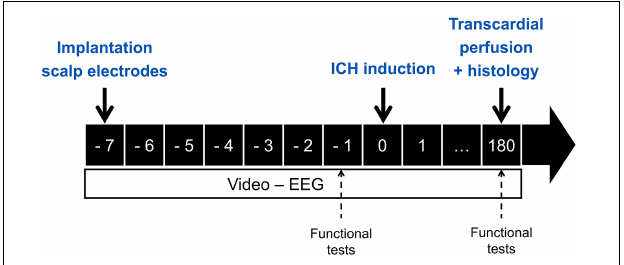
FIGURE 1 | Overview of the timing (in days) of the experimental